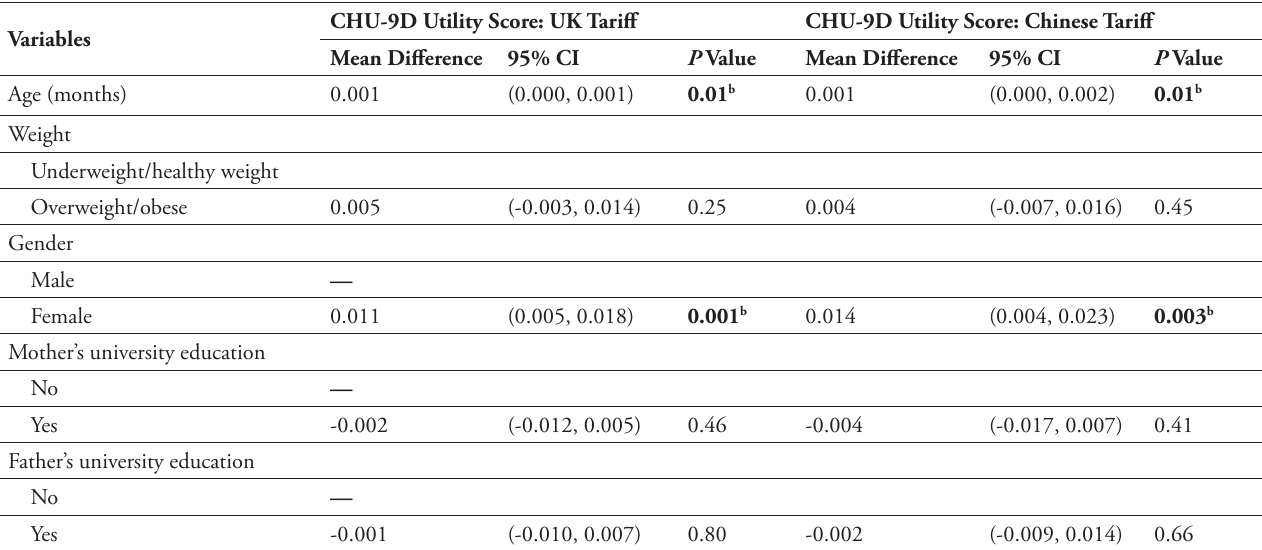
Table 3. Linear Mixed Regression Model to Explore Association Between Weight Category and HRQOL a